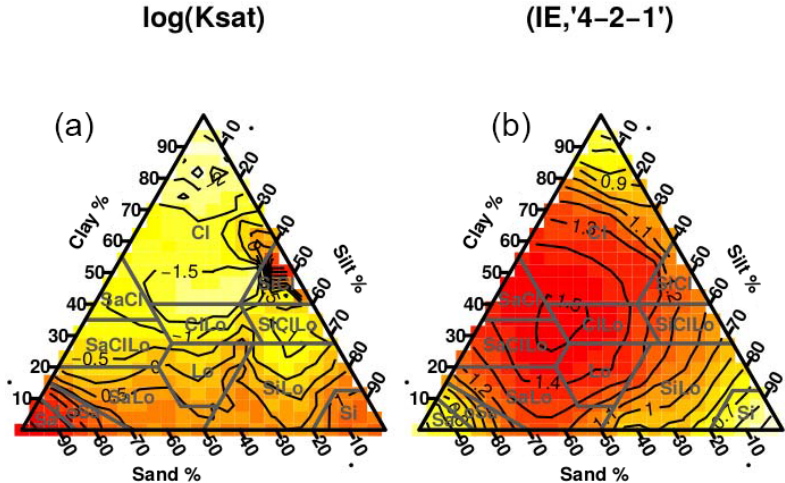
Figure 4. Ternary representations for ln K sat and (IE,“4-2-1”) represented in the USDA textural triangle.